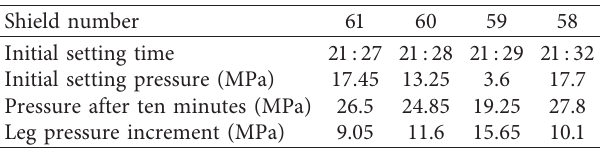
Table 2: Typical difference in leg pressure increment in the same period.